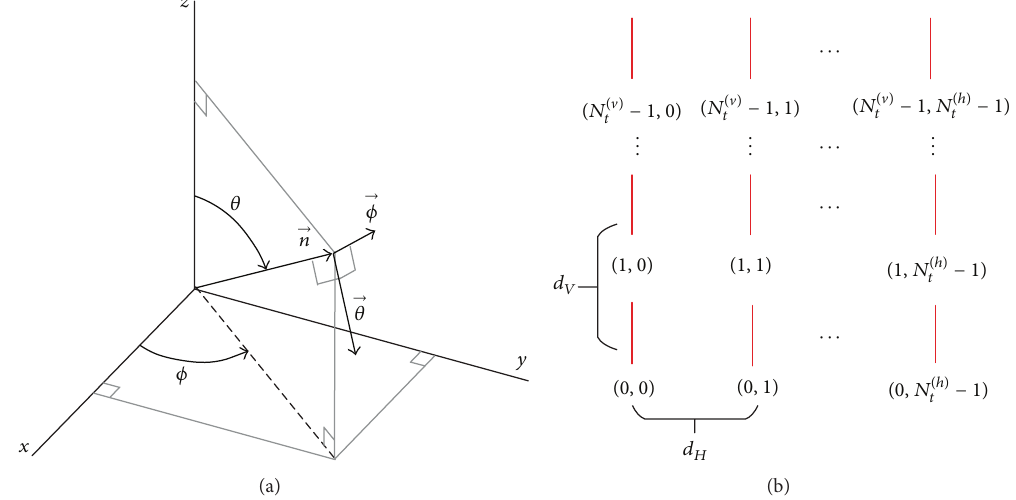
Figure 2: (a) 3D spherical coordinate system and (b) antenna array